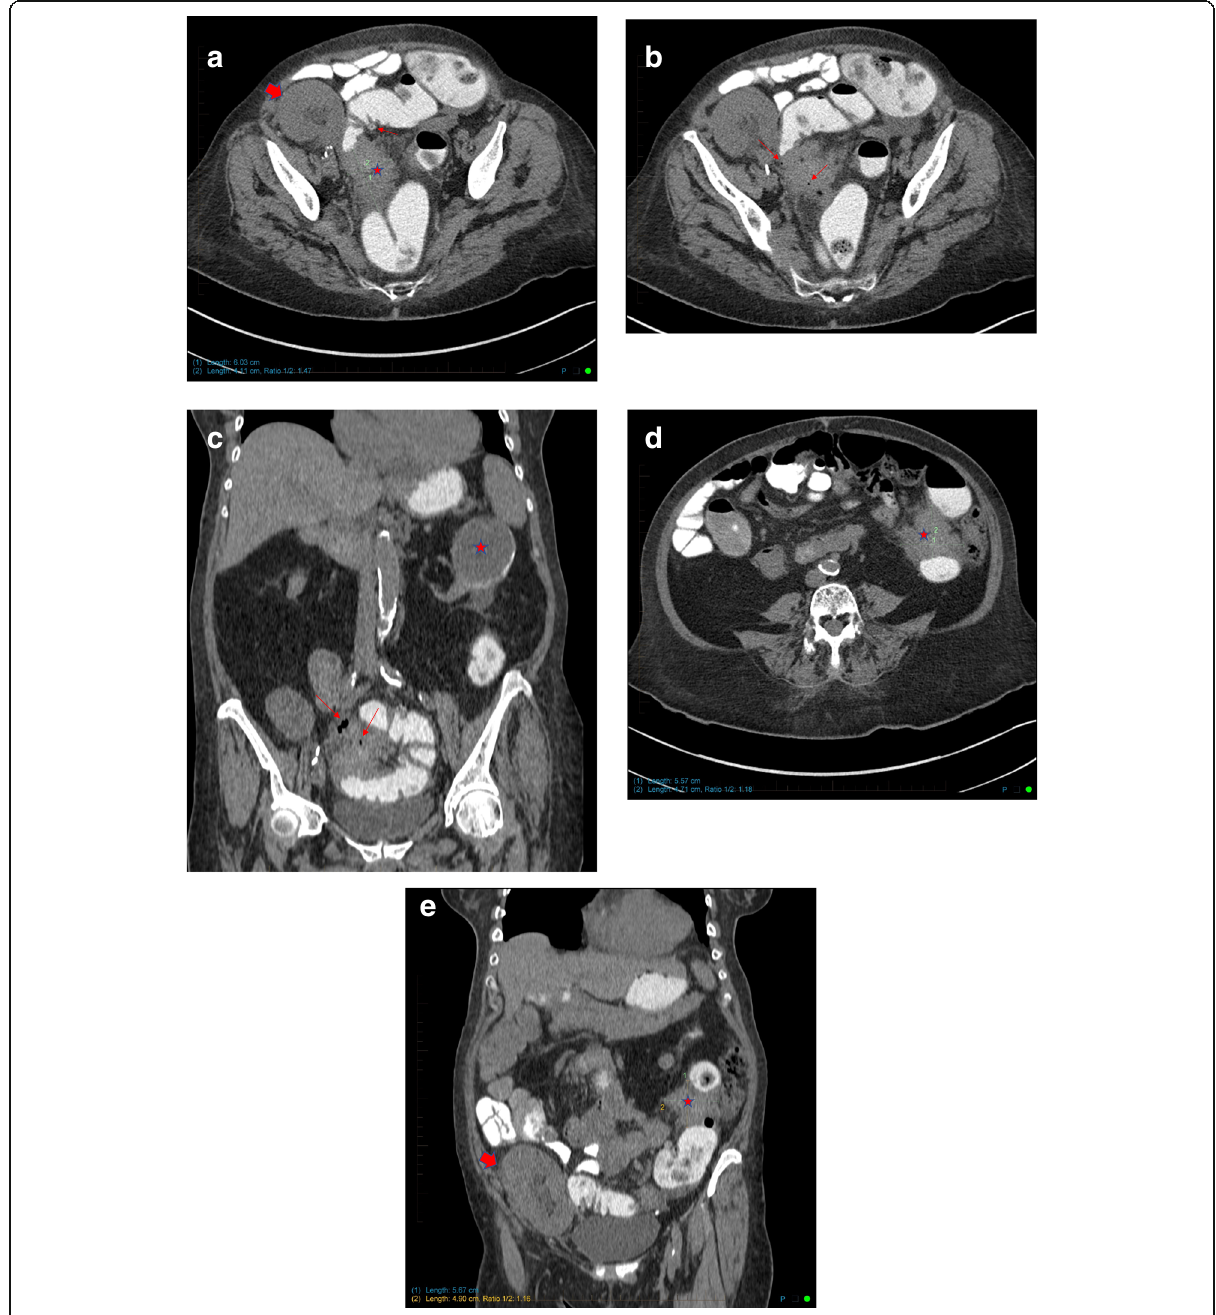
Fig. 1 Abdomino-pelvic CT scan images. a Axial image showing a 6x4cm non stenotic mass (red star) adjacent to the distal sigmoid in a diverticular segment (thin red arrow). The transplanted kidney is partially seen in the right lower quadrant (thick red arrow). b and c Axial and coronal images showing small bubbles of extra-luminal air trapped in the mesosigmoid mass (red arrows). Incidentally, a partially calcified renal lesion is seen in the left native kidney (red star). d and e Axial and coronal images showing a second non stenotic mesocolic mass adjacent to the descending